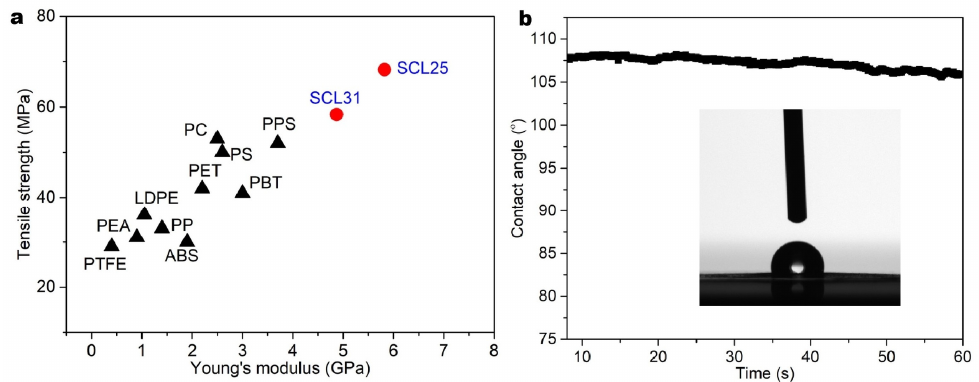
Figure 6. Mechanical properties ( a ) of different types of composite films and contact angles of SCL25 ( b